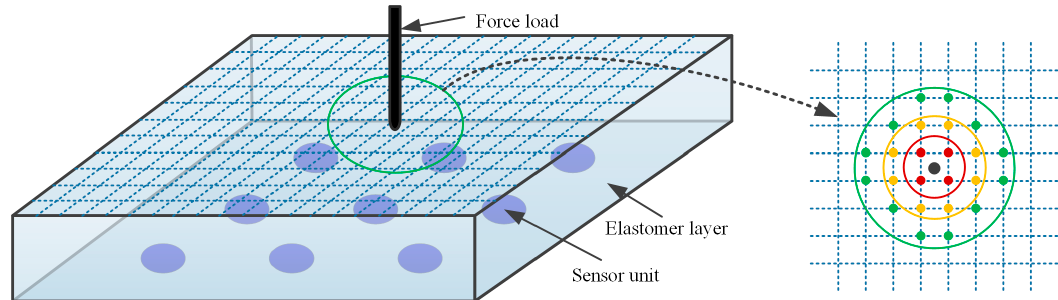
Figure 1. Schematic of a sensing system with mesh grids on the surface of the elastomer cover. The inset displays the load point location in the plane that the black point represents the load point and the colorful points represent the mesh points with different distances to the load point.